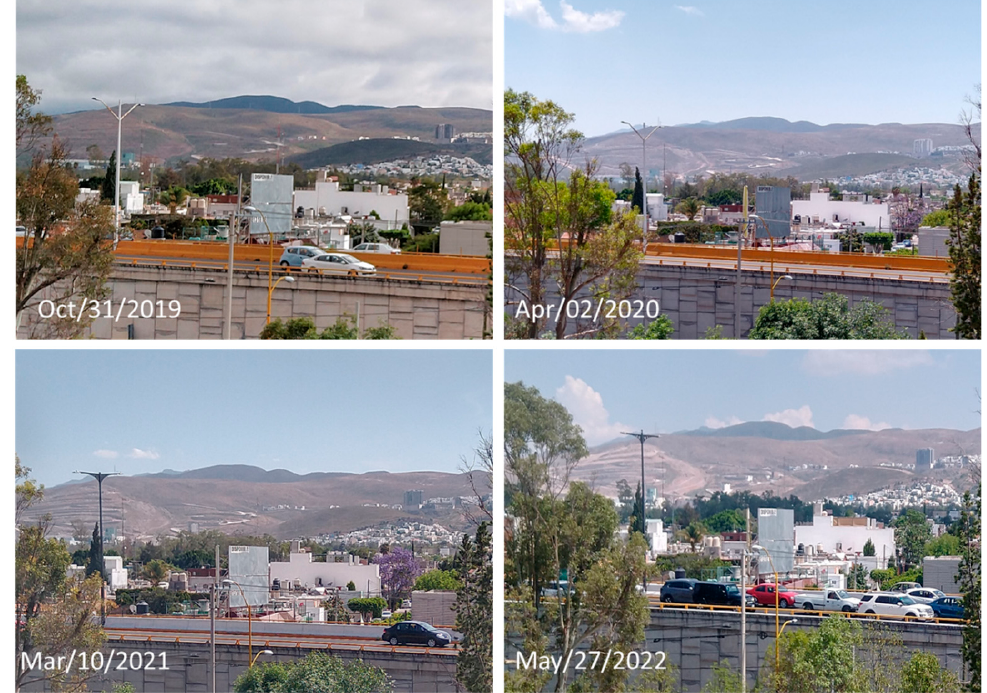
Figure 2. Land-use changes on the slope hill in recent years, west side of the micro-watershed.